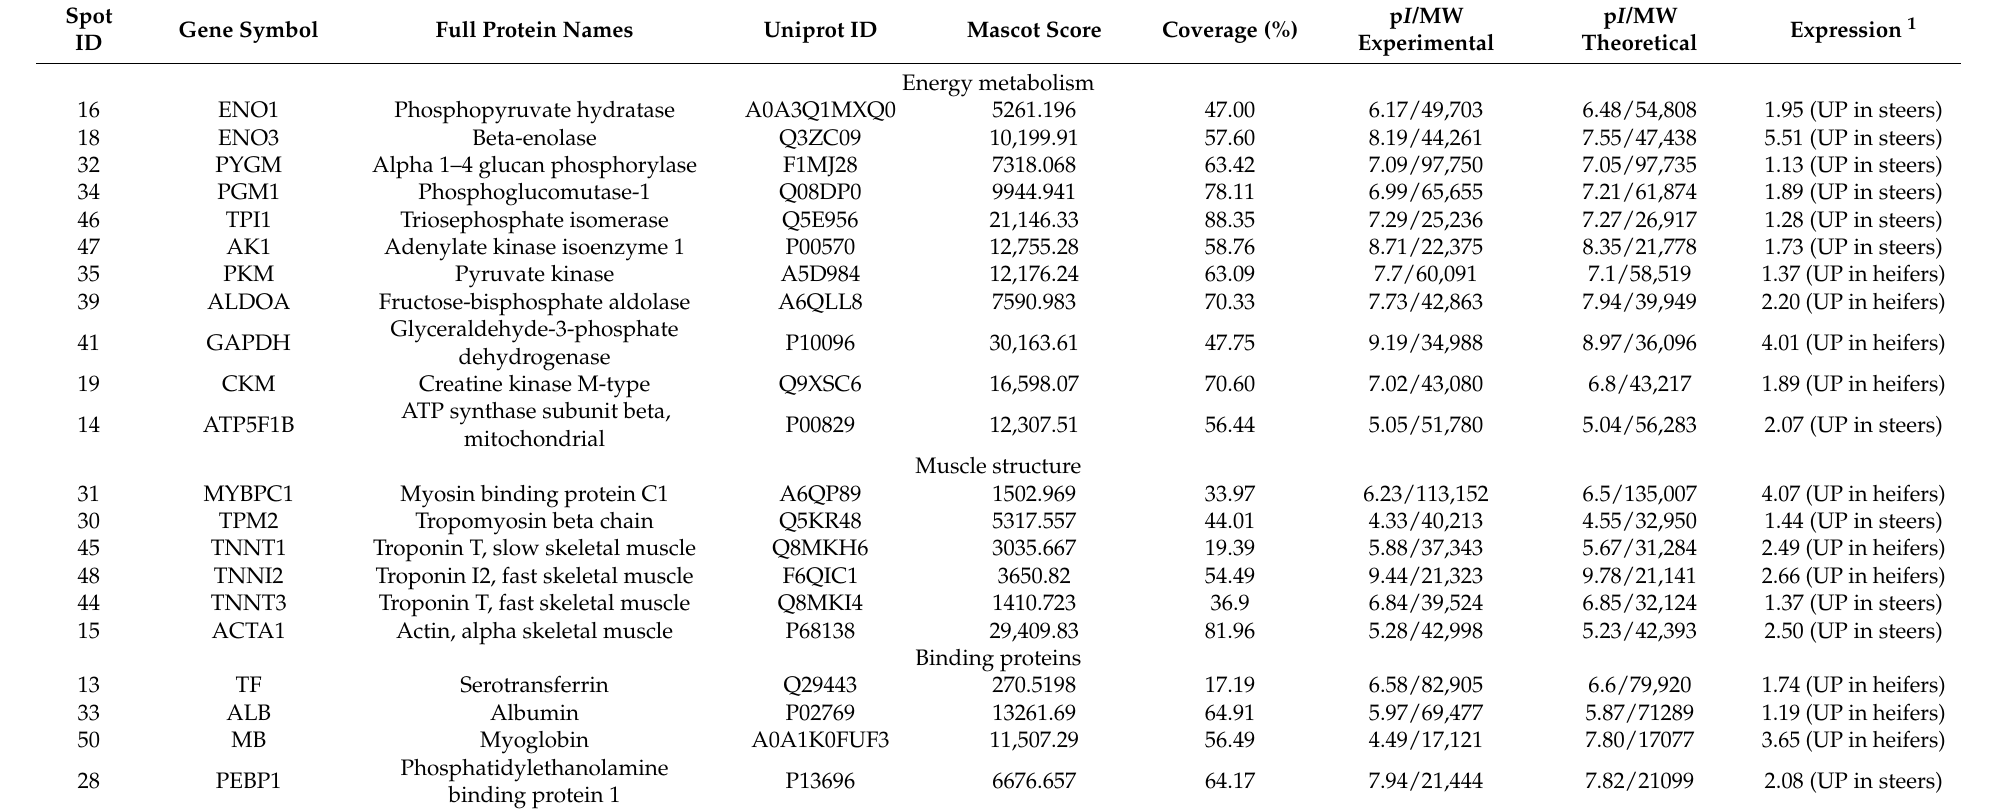
Table 3. Proteins separated by two-dimensional electrophoresis (2D-PAGE) and identified by mass spectrometry (ESI-MS/MS) in samples of Longissimus